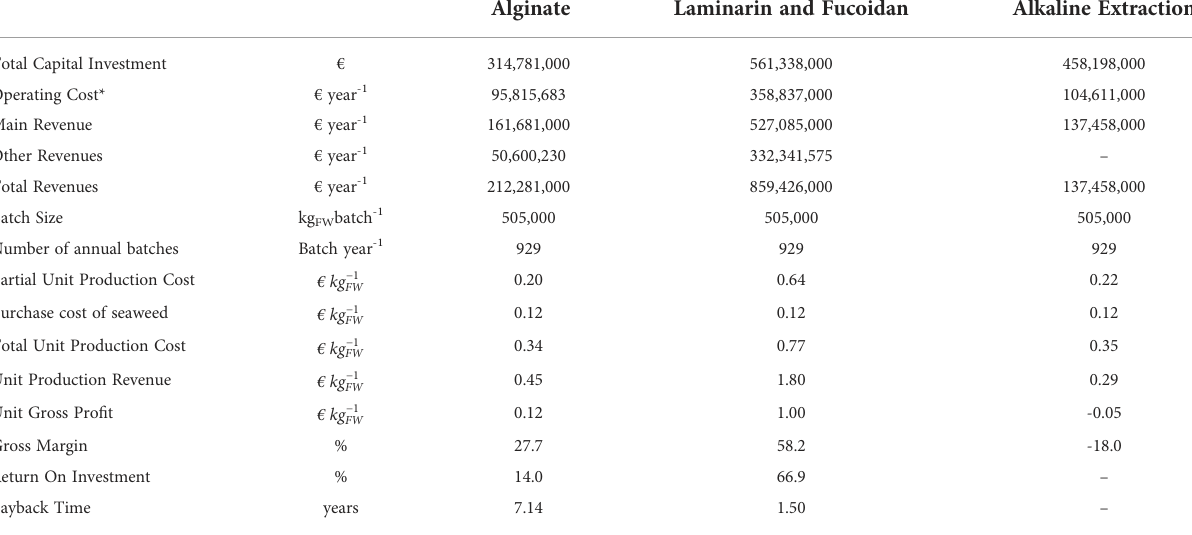
TABLE 4 Executive summary for two biore fi nery scenarios of S. latissima , with alginate as main product and with laminarin and fucoidan as main products.